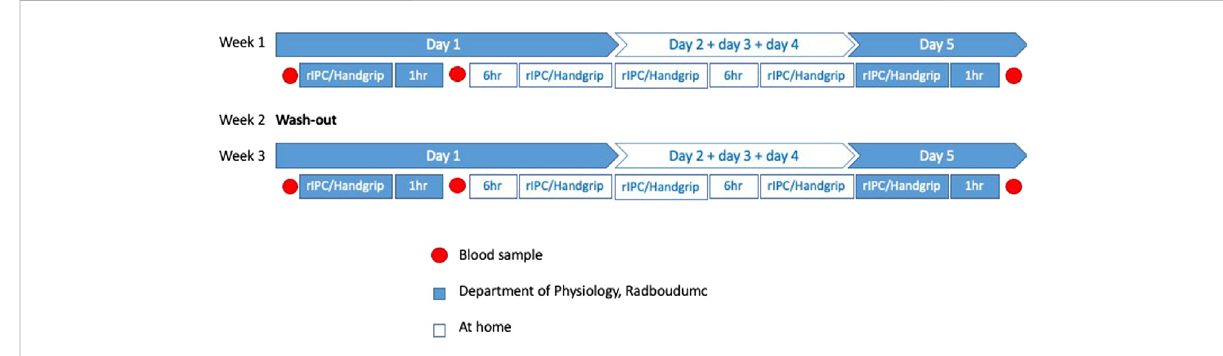
FIGURE 1 Overview study design. An overview of all the measurements in this cross-over study. rIPC = Remote ischemic